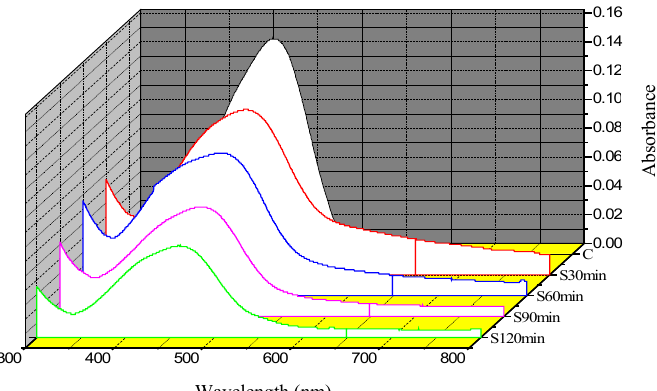
Fig. 7(a): Degradation of Methyl orange dye using GS-SAgNPS